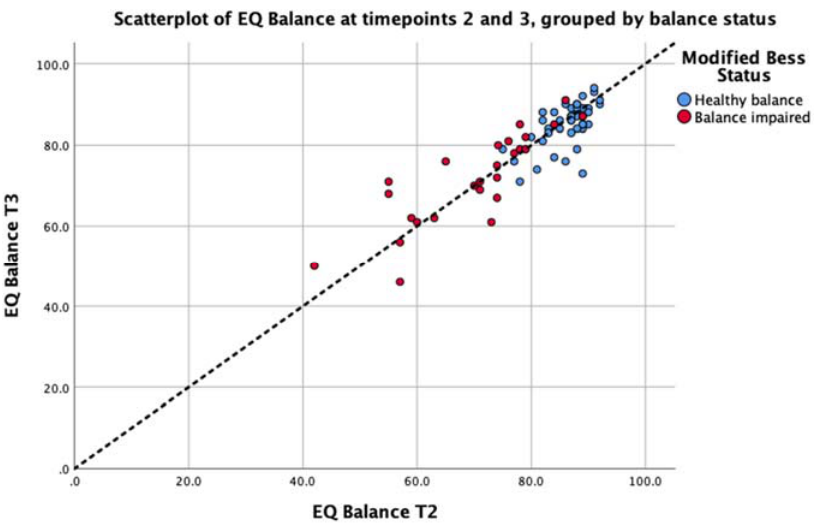
Figure 5. Scatterplot depicting the test–retest data for the EQ Balance task taken at Timepoint 2 (T2) and Timepoint 3 (T3) for the balance-impaired group (red) and healthy group (blue). The unity line (y = x) is represented by the dashed line.